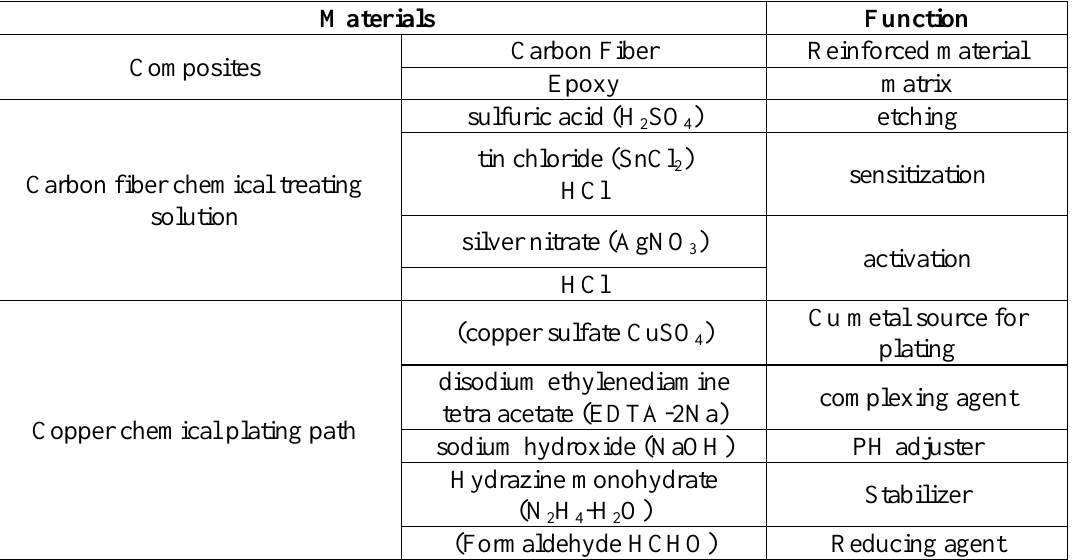
Table 1: List of materials used and its